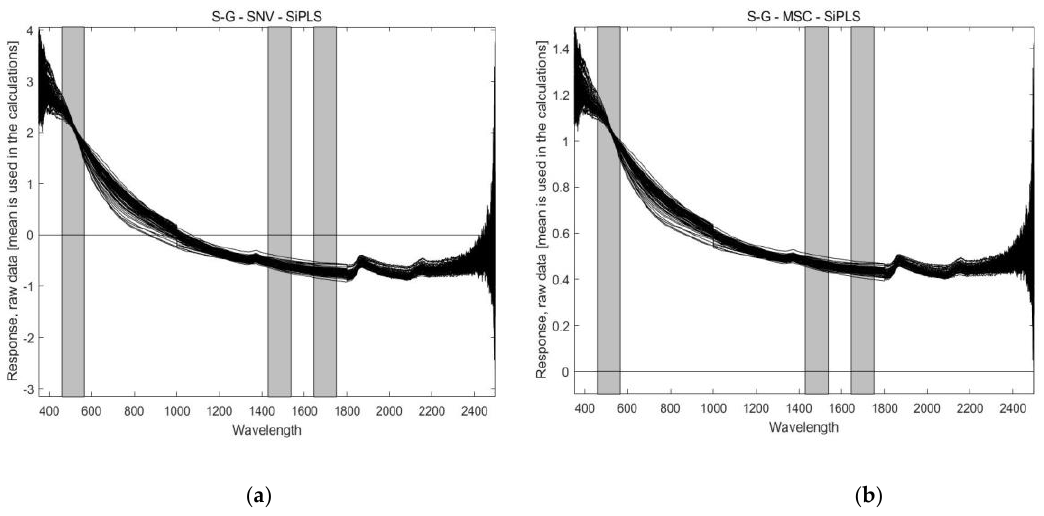
Figure 7. Interval combination results of SOM content VIS-NIRS based on SiPLS. ( a ) Synergy intervals of S-G-SNV pretreatment spectra and ( b ) synergy intervals of S-G-MSC pretreatment spectra. Table 5. Band optimization results of two pretreated spectra by